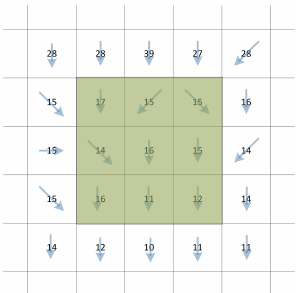
Figure 2: D8 algorithm flow directions